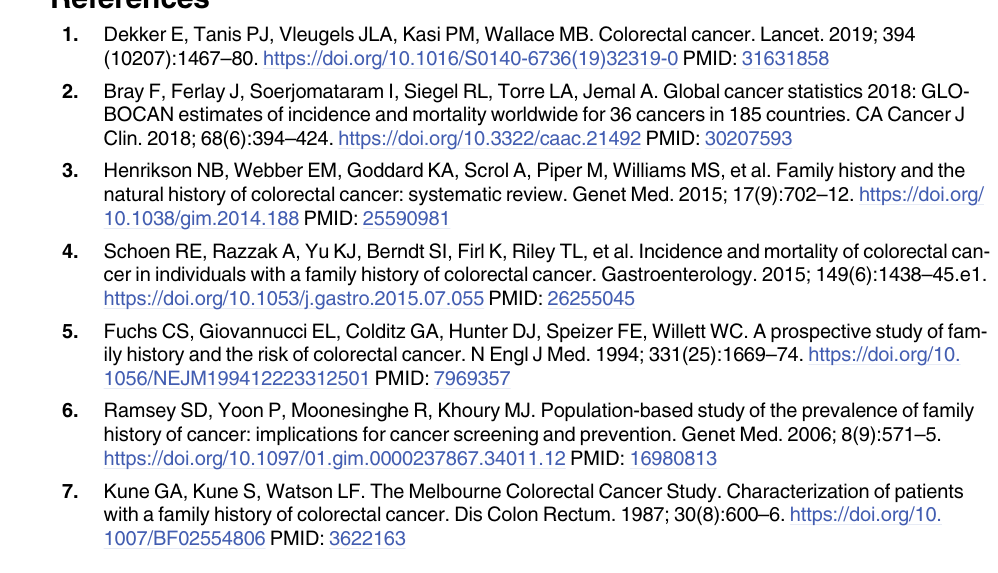
S2 Table. Standardised incidence ratios (SIR) by age group for full lifetime and 10-year risk (combined